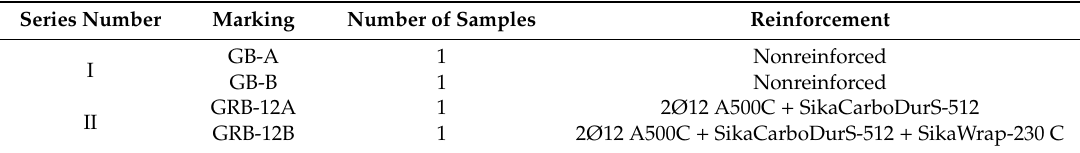
Table 1. Bulk samples for experiment